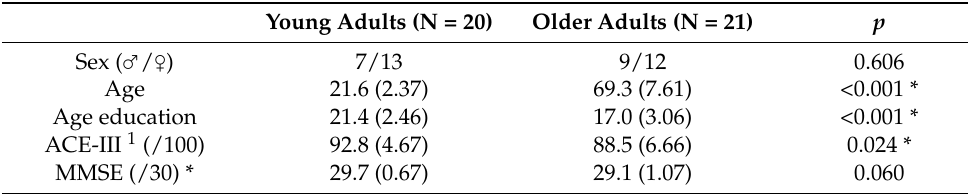
Table 1. Demographic